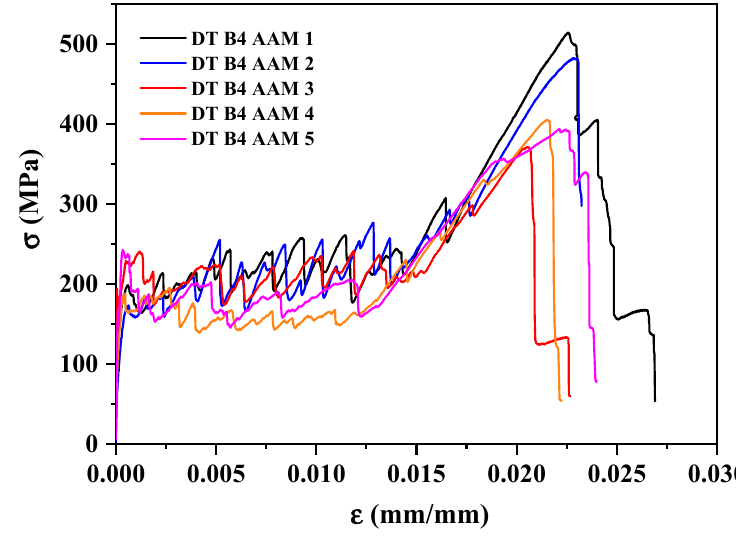
Figure 12. Tensile test: stress vs . strain response curves.